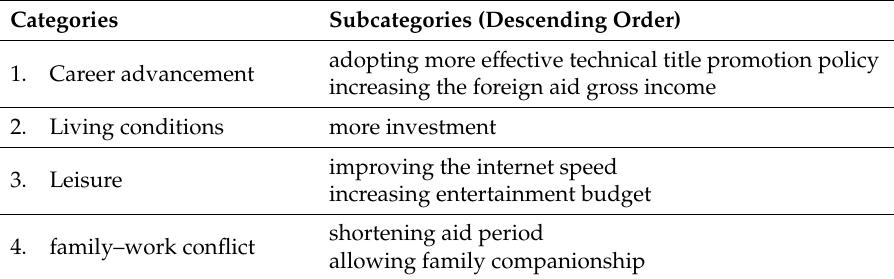
Table 3. Suggestions for motivating CMATMs